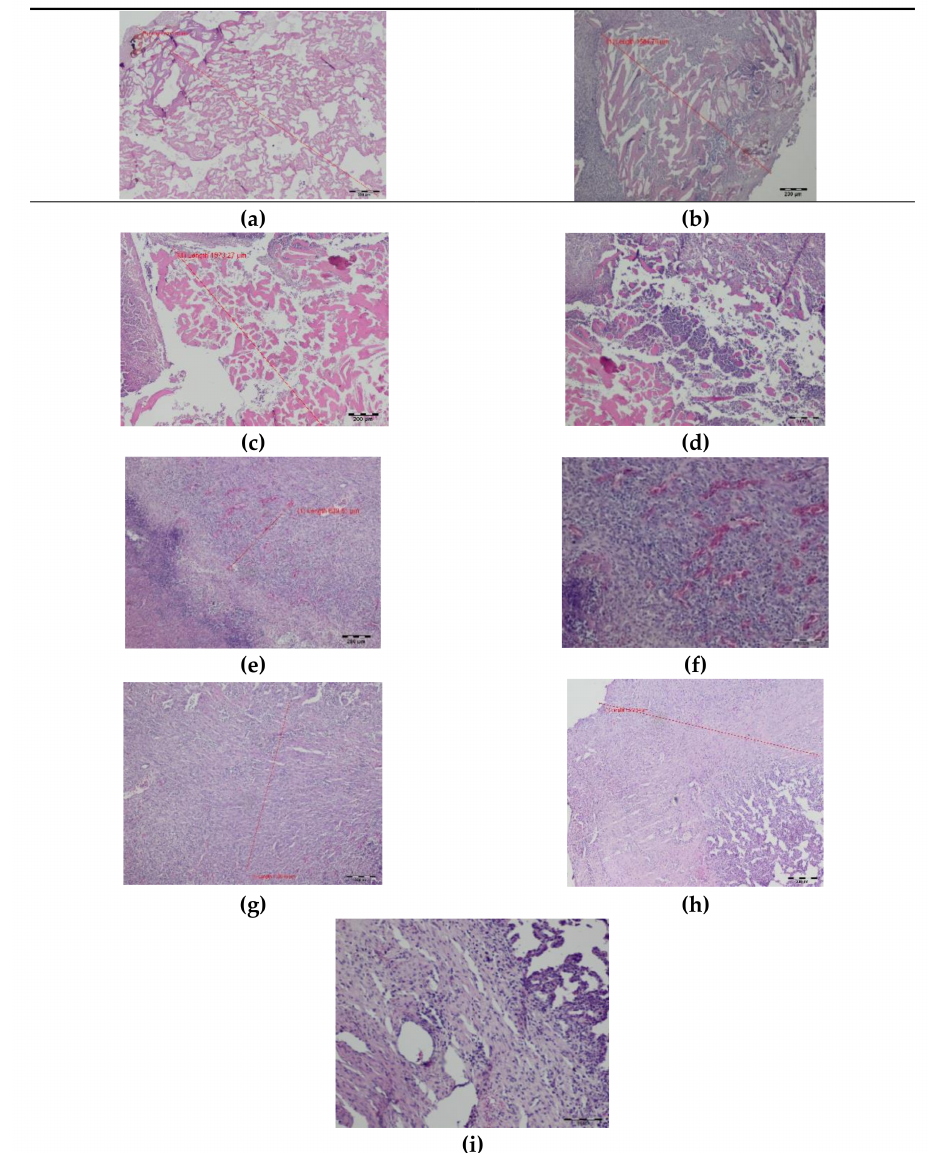
Figure 4. Histopathology of the pig lung seven days after surgery with a diode laser (DL): ( a – c ) superficial thermal changes after DL laser cutting, magnification 40 × ; ( d , e ) granulocyte infiltration zone, magnification 40 × ; ( e , f ) granulation tissue band, magnification 40 × ( e ); 100 × ( f ); ( g , h ) con- nective tissue proliferation (fibrosis), magnification 40 × ; ( i ) border between thermal damage and healthy tissue, magnification 100 × ; HE